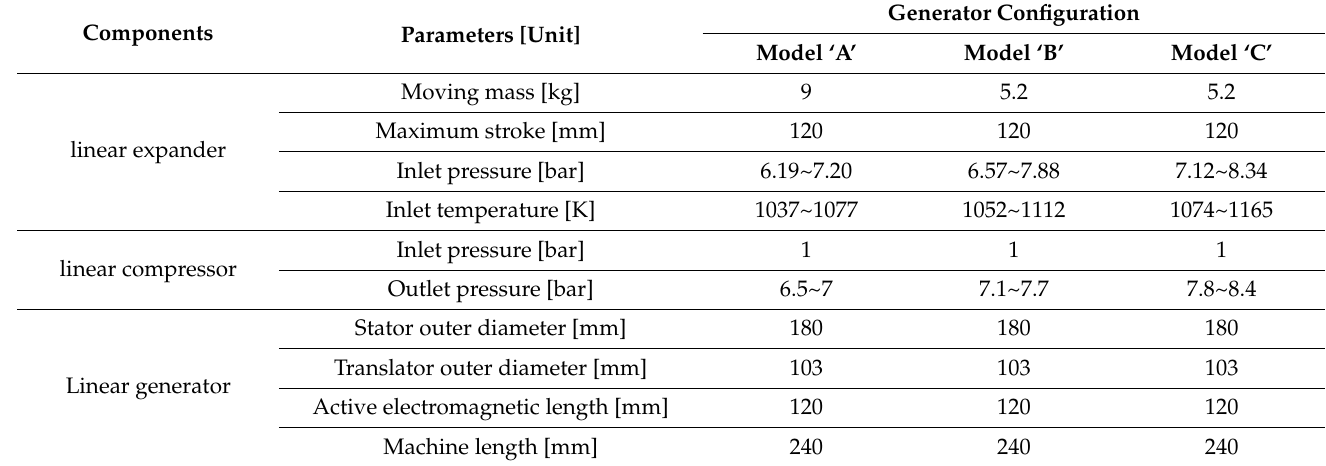
Table 1. Design parameters of the